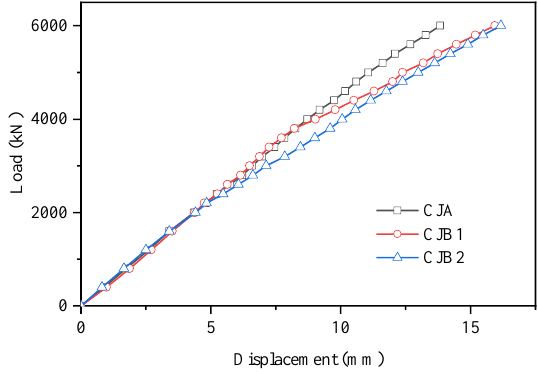
Figure 11. Load–displacement curves of composite joints.